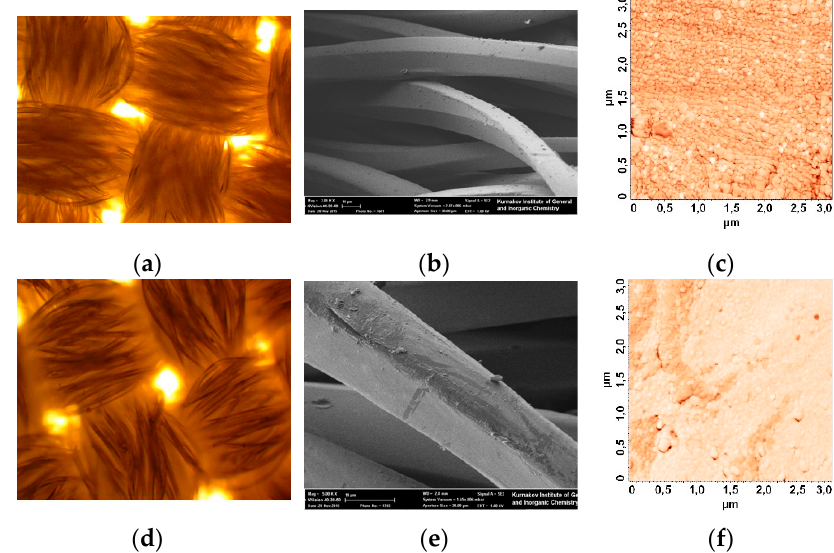
Figure 1. Surface morphology of the polyester fabric activated with a NaOH solution: ( a – c ) without a coating; ( d – f ) with a TiO 2 -based coating. Visualization by the methods of: ( a ) Optical microscopy; ( b ) Scanning electron microscopy; ( c ) Atomic-force microscopy.